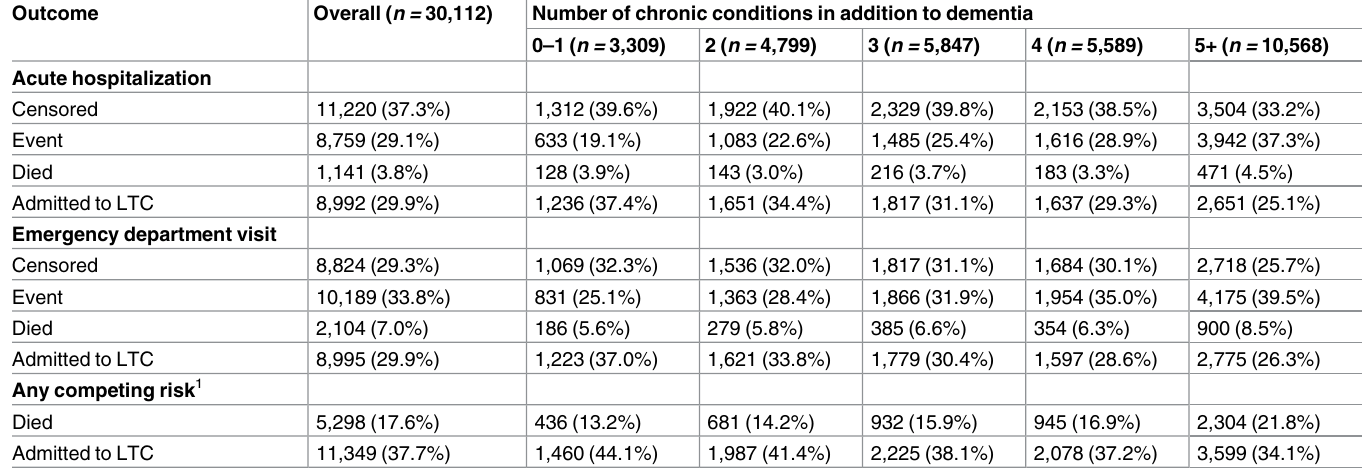
Table 2. Proportion of long-stay home care clients with dementia in Ontario in 2012 who experiencedeach outcome (any acute hospitalization or any emergency department visit) during the 1-y follow-up period, accounting for multiple competing risks (death, long-term care admission, cen- soring at end of